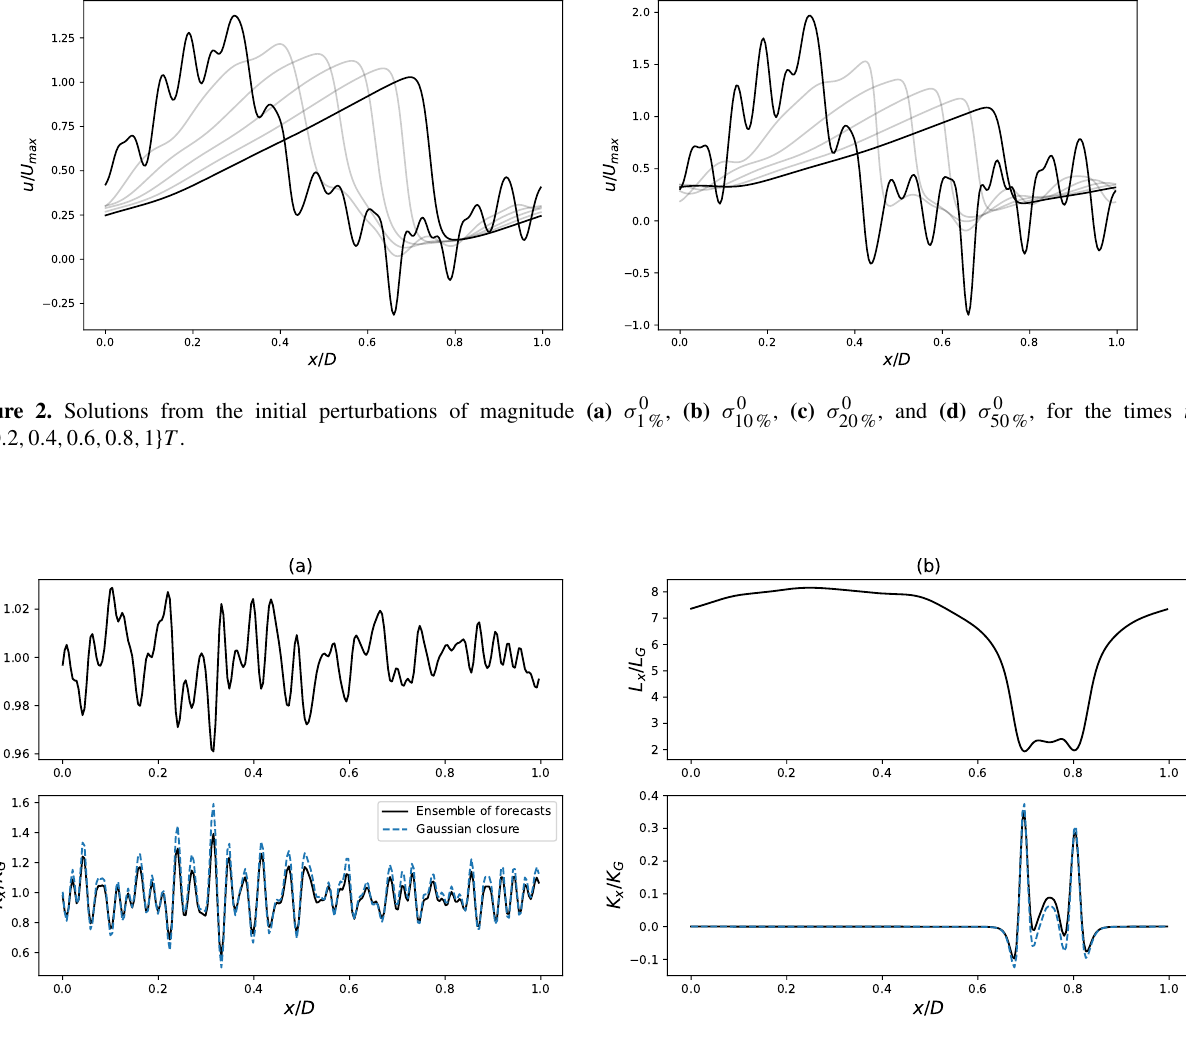
Figure 3. Diagnoses of the length scale L x normalized by L G (top panels) and of the kurtosis normalized by K G = 1 deduced from the ensemble of forecast with initial uncertainty magnitude σ 0 kurtosis is compared with its closure K GC x = 1